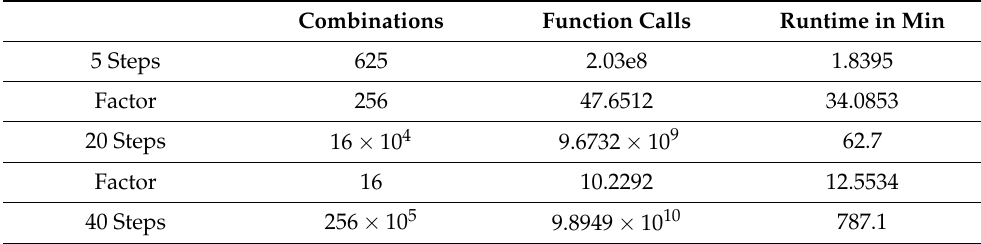
Table 5. Runtime of OptTopo depending on the discretization: The computational effort increases with the number of steps in the grid, but this increase is slower than the expected exponential